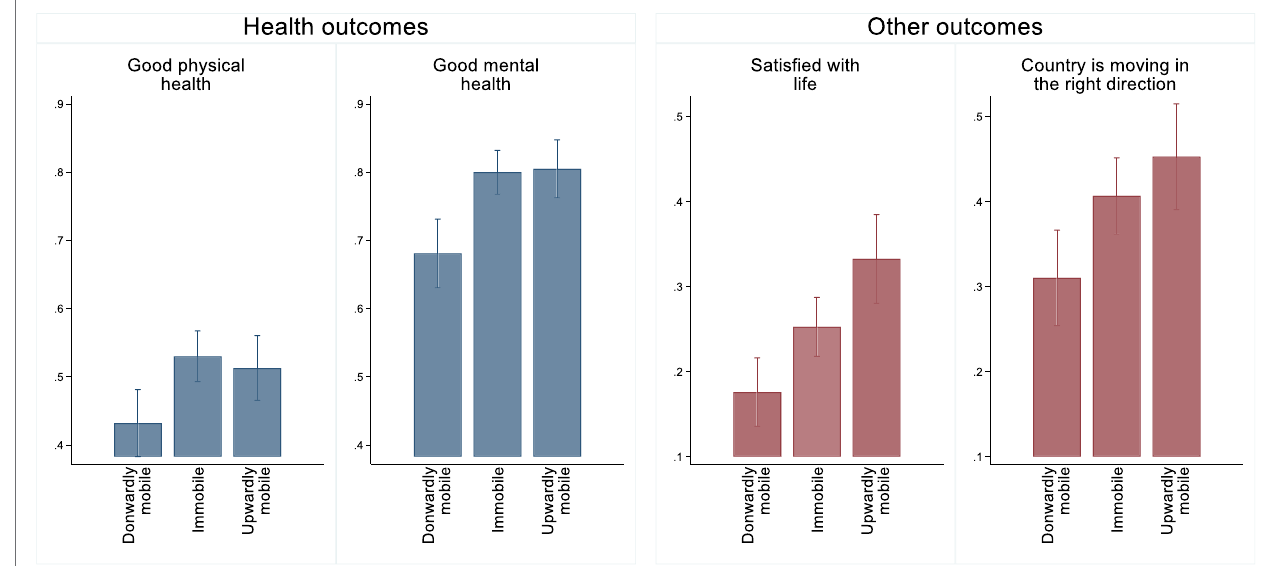
FIGURE 1 | Perceived social mobility and various health and wellbeing outcomes, predictive margins from linear probability models. Bars show 95% confidence intervals. Models account for respondents’ age, gender, parental education, own education, material deprivation index, unemployment status, settlement type, number of children, IDP status, and the fixed effects for the interview